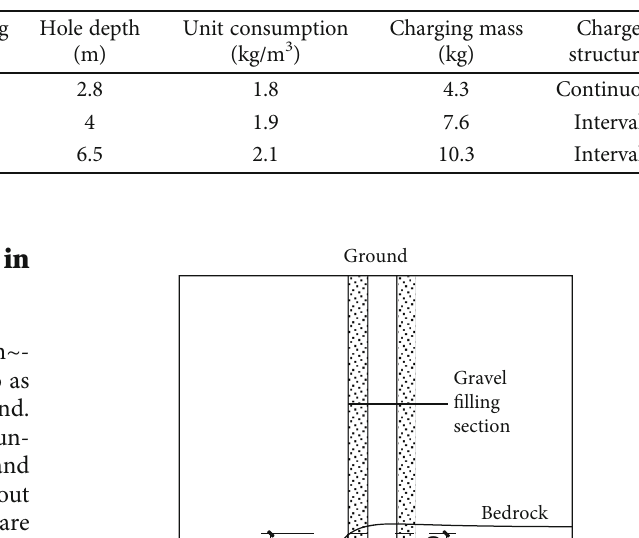
Figure 7: Layout diagram of the blasting holes. Table 5: Bedrock blasting parameters.